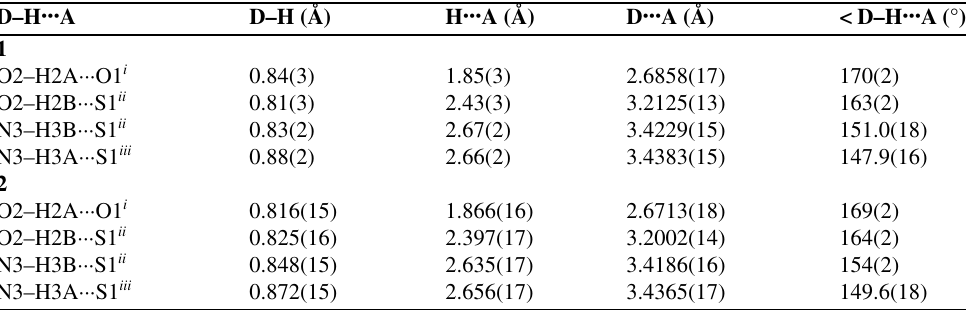
Table 3. Hydrogen bond geometry in 1 and 2 .